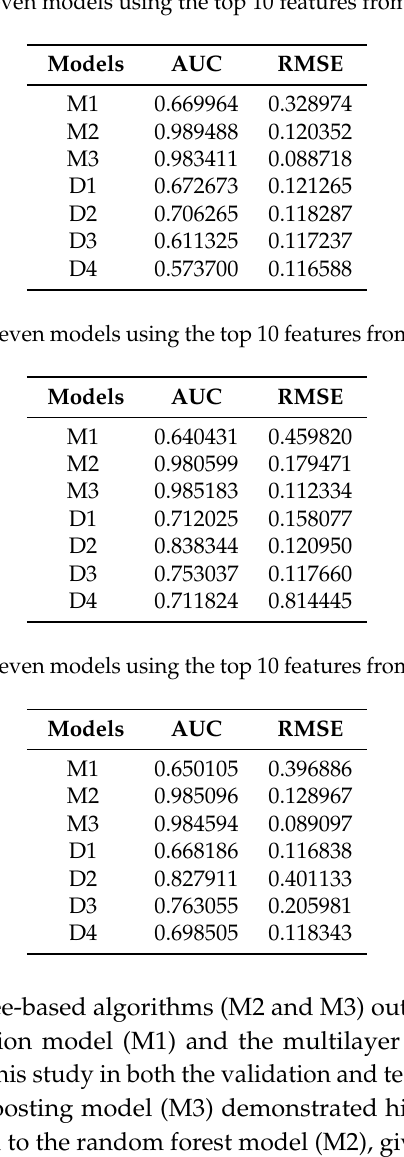
Table 9. Performance for the seven models using the top 10 features from model D2 on the test dataset.